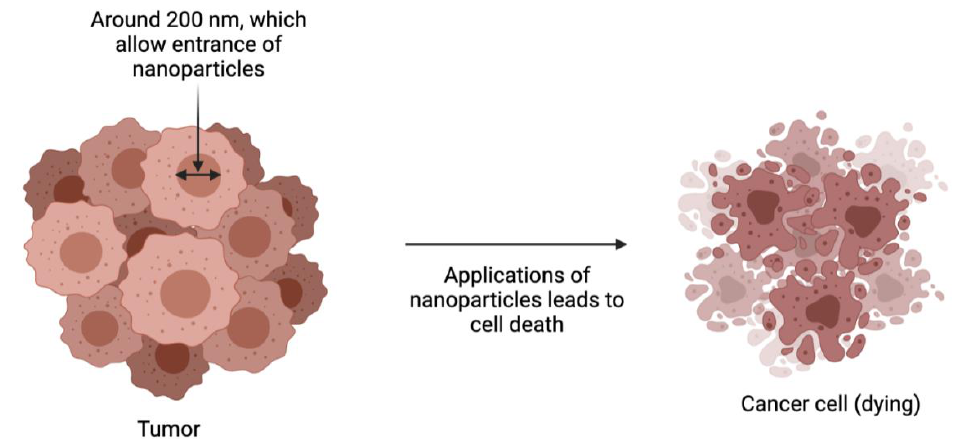
Figure 1. Owing to the EPR effect (enhanced permeability and retention effect), nanoparticles up to 200 nm can enter and accumulate in the tumor cells, and cause tumor cell death (created with BioRender.com).